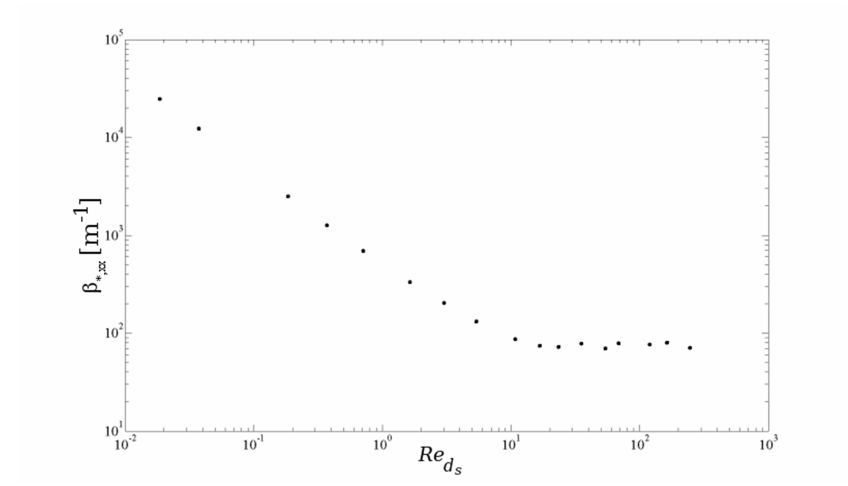
Figure 9. Inertial coefficient ( β ∗ , xx ) versus Reynolds number for Foam 1 in Table